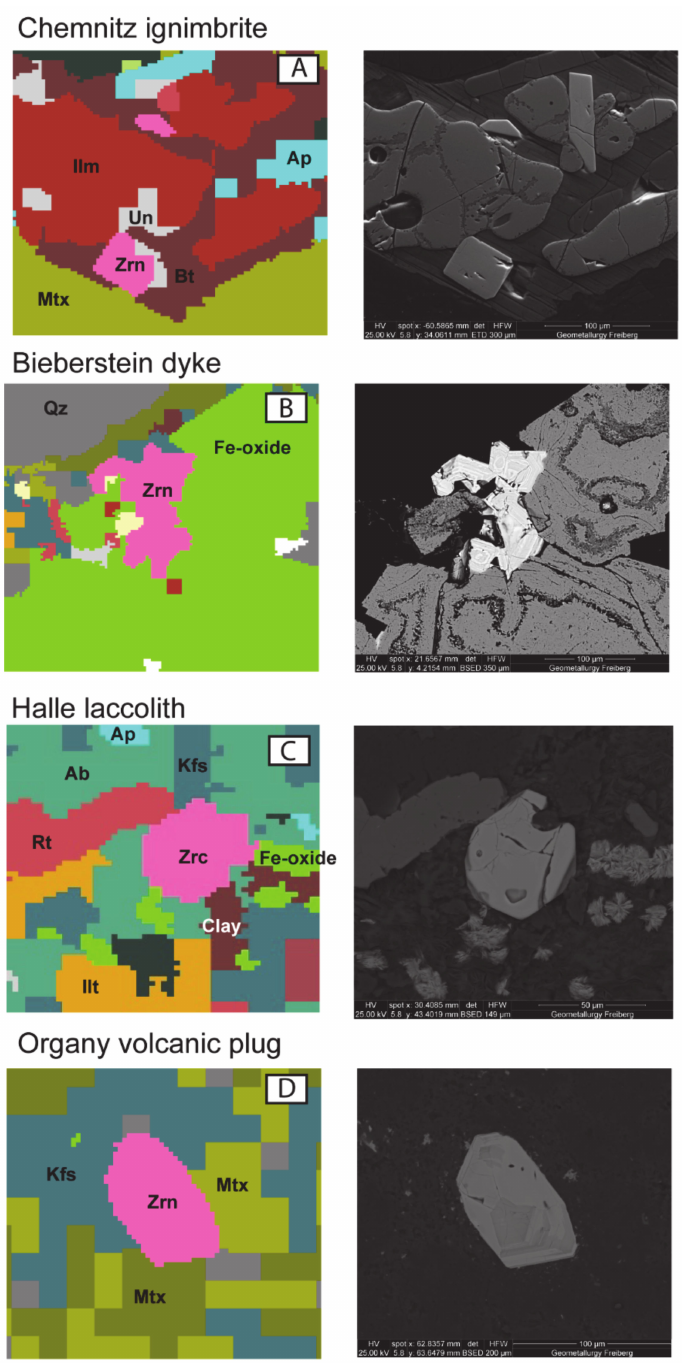
Figure 5. Examples of zircon associations in MLA images, and examples of di ff erent structural positions of zircon in BSE images. ( A ) Chemnitz ignimbrite, showing zircon and other accessories in ilmenite-rich glomerocryst. Interestingly one zircon is missing from the MLA image; however, this was the only case where this happened. ( B ) Bieberstein dyke showing the typical association of zircon with Fe-oxide. This interesting glomerocryst of several zircons was detected as a single grain by MLA. ( C ) Halle laccolith, showing zircon associated with accessory minerals in a late vein. ( D ) Organy lava dome, showing a typical matrix-associated zircon. Ilm—ilmenite, Zrn—zircon, Ap—apatite, Bt—biotite,